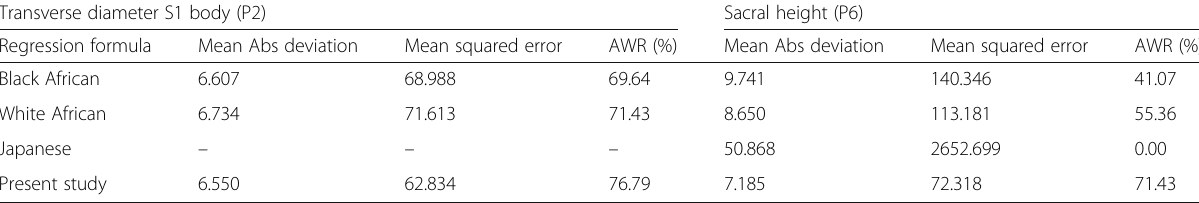
Table 10 Comparison of estimated stature by using formulae from different studies in validation